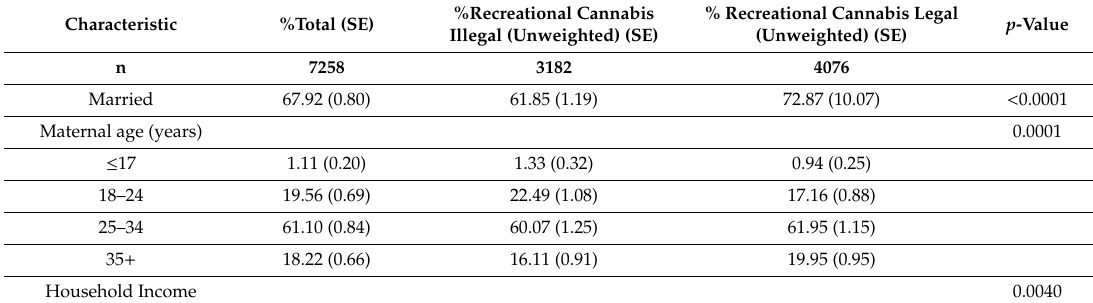
Table 1. Characteristics of sample by recreational cannabis legality in 2016 a